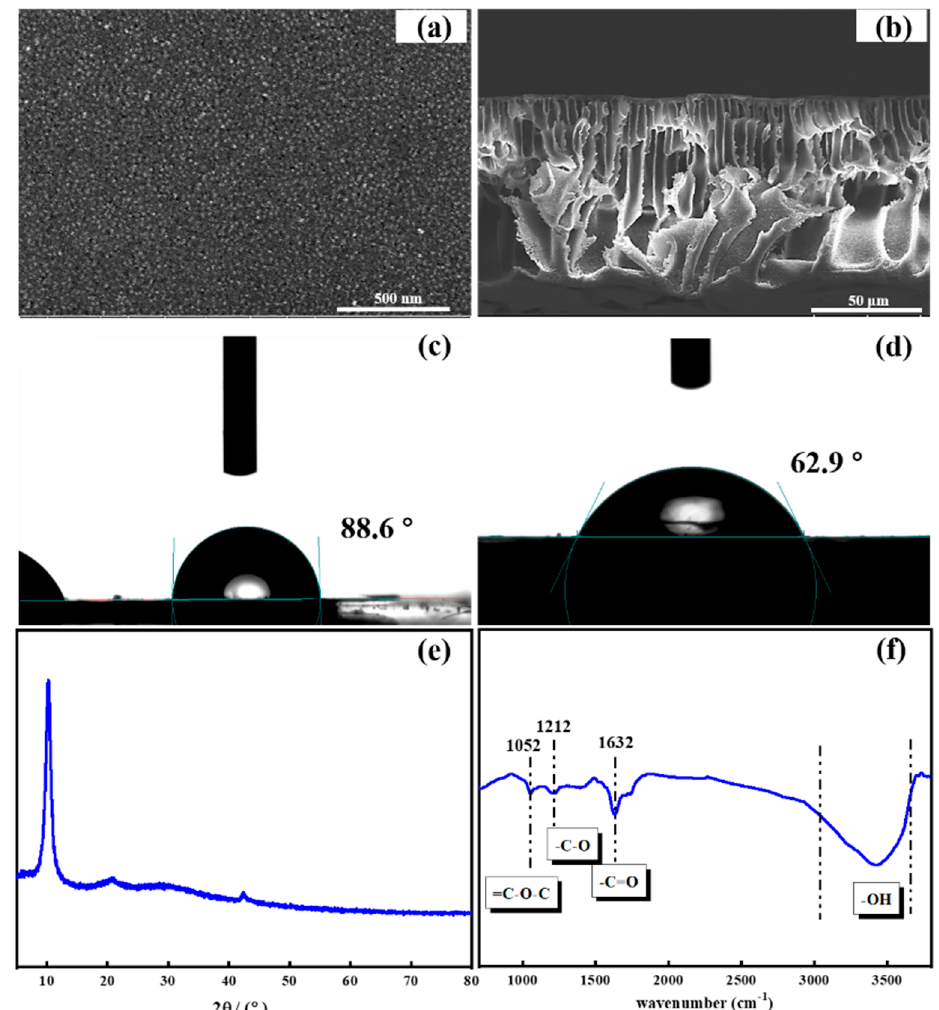
Figure 2. ( a , b ) Scanning electron microscopy (SEM) images of prepared graphene oxide (GO)– polysulfone (PSF) composite membrane; ( c , d ) water contact angle of original PSF and GO-PSF composite membrane; and ( e , f ) X-ray diffraction (XRD) and Fourier transform infrared spectroscopy (FTIR) of the prepared GO nanosheets.